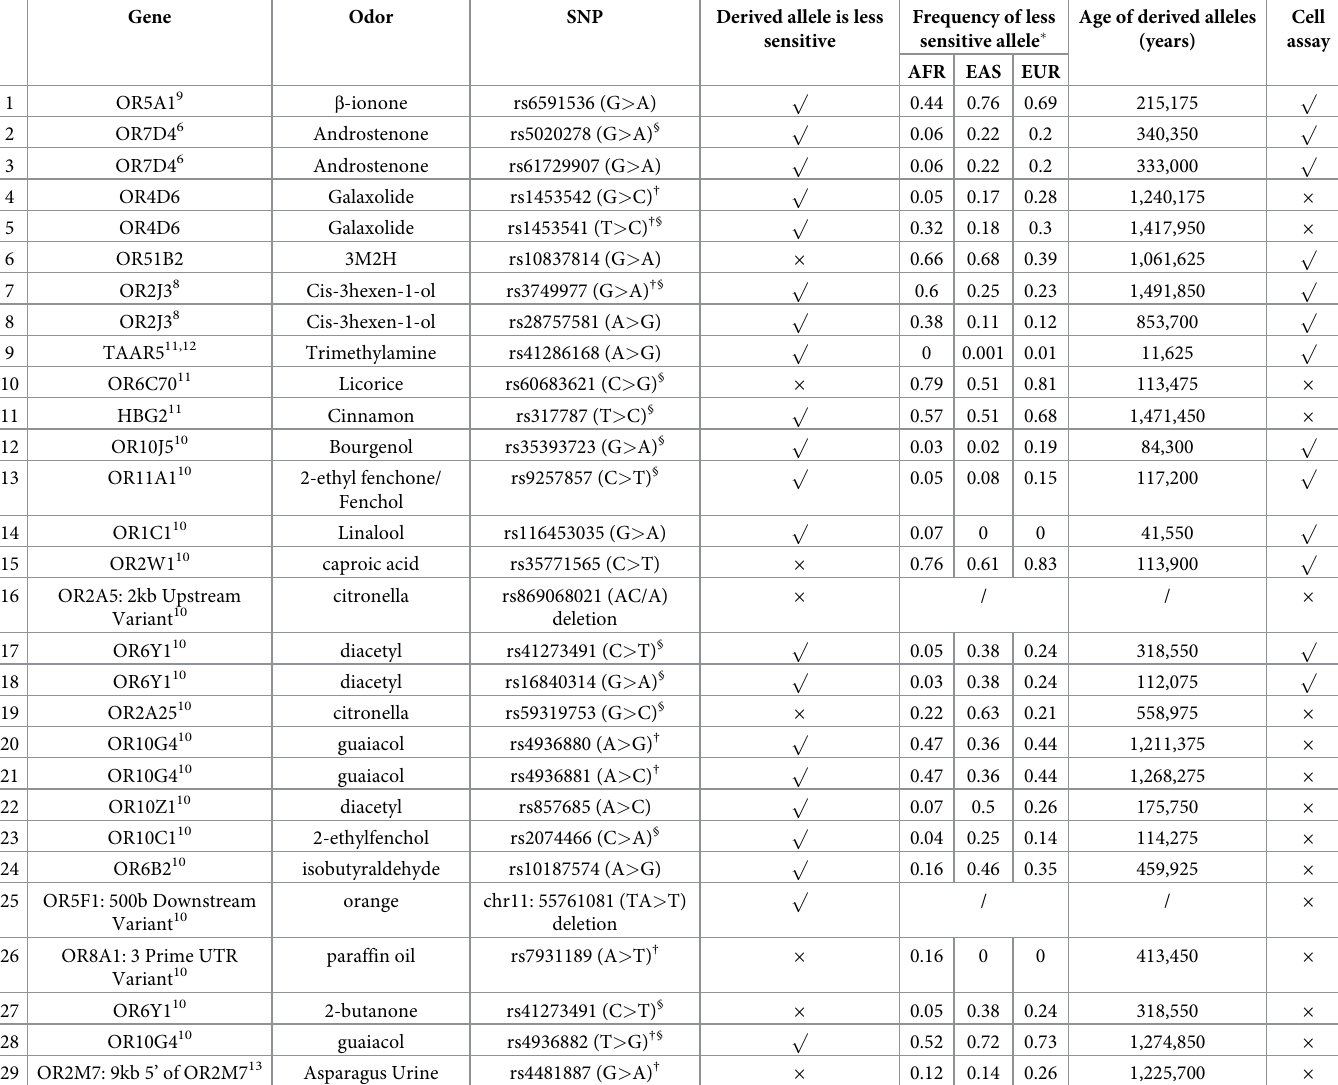
Table 1. Variant age and effect of derived allele on odor perception. In a literature review, derived alleles corresponded with decreased sensitivity to odor in 21 out of 29 cases, and 11 out of 13 cases with functional validation. All but two variants predate the estimated ages of the East Asian and European population